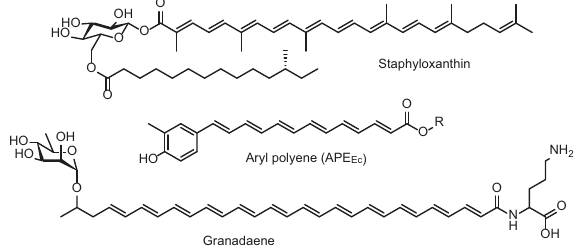
Fig. 1 Chemical structures of pigmented fi tness factors localized in the cell envelope of bacterial pathogens. Staphyloxanthin is the carotenoid produced by S. aureus responsible for the organism ’ s characteristic golden color (top). Aryl polyenes are yellow pigments, widespread among Gram-negative pathogens, for example, APE Ec from uropathogenic E. coli (middle). Granadaene is an ornithine rhamno-polyene that constitutes the red pigmentation in Group B Streptococcus (bottom) 1,16,17 .